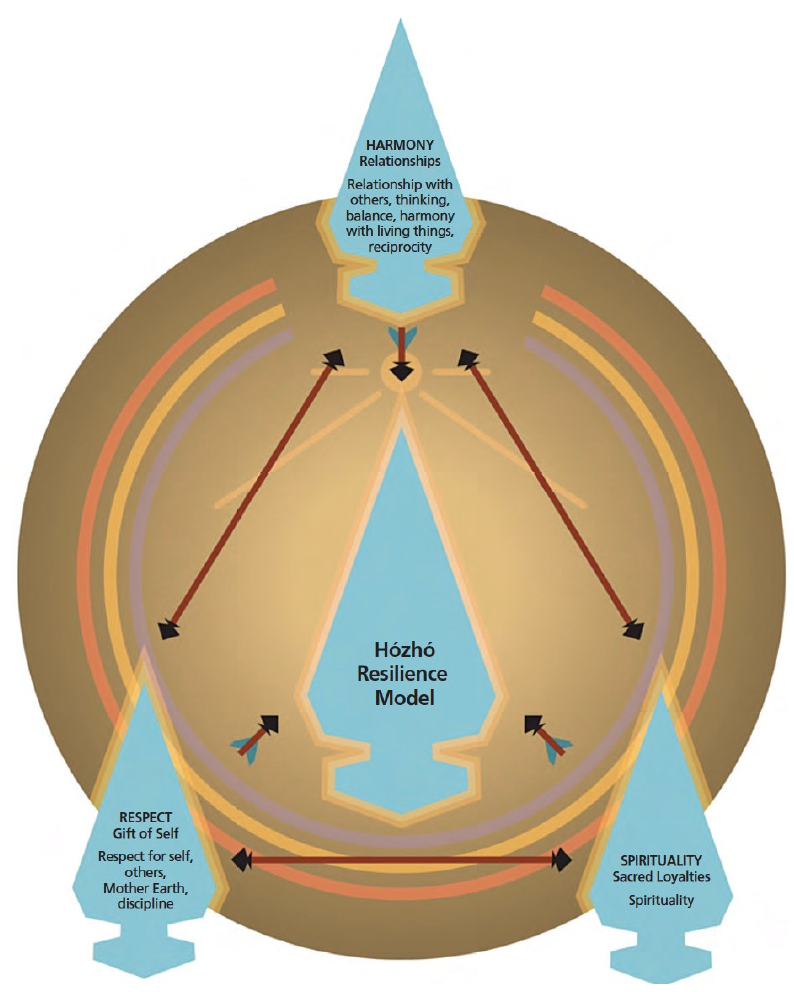
Figure 1. Constructs of the Hózhó Resilience Model [31].